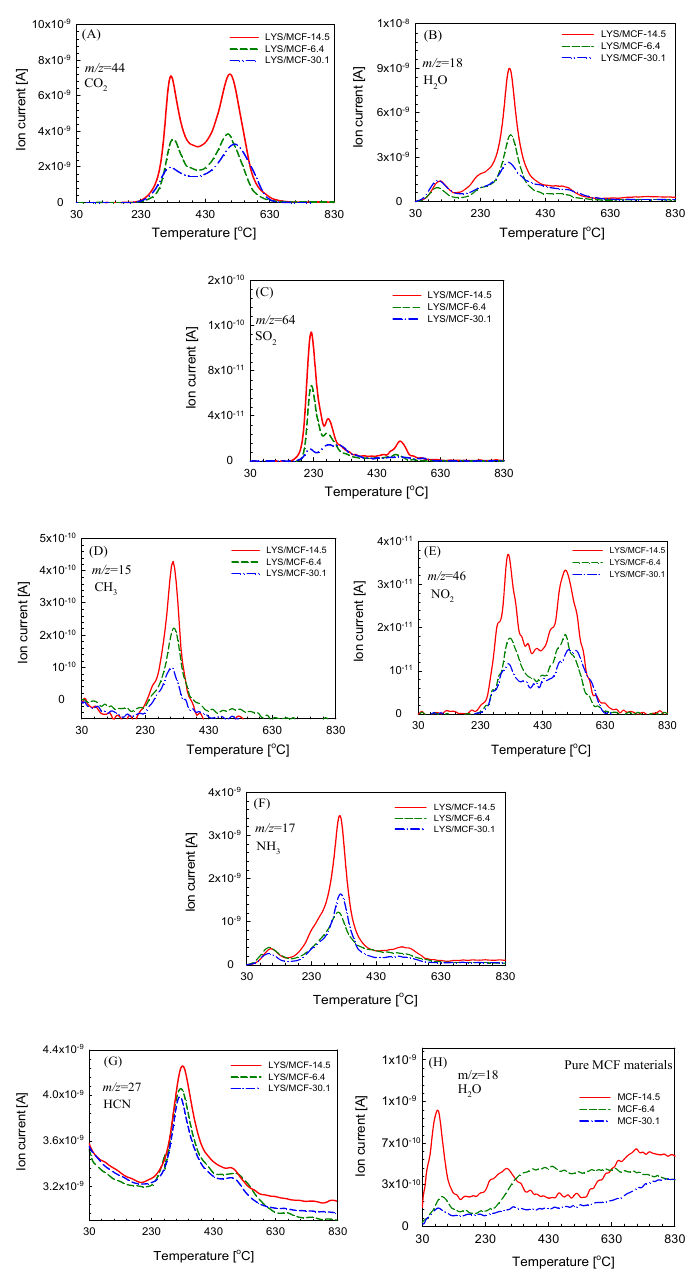
Figure 6. QMS profile of gaseous products emitted during decomposition of three selected LYS/MCF-14.5, LYS/MCF-6.4, LYS/MCF-30.1 composites vs. temperature at m/z : ( A ) 15 (CO 2 ); ( B ) 18 (H 2 O); ( C ) 64 (SO 2 ); ( D ) 15 (CH 3 ); ( E ) 46 (NO 2 ); ( F ) 17 (NH 3 ); ( G ) 27 (HCN) in air atmosphere; ( H ) MS profile of H 2 O vs. temperature for pure MCF-14.5, MCF-6.4 and MCF-30.1 supports. TG/QMS/FTIR results significantly indicate the formation of various gaseous products during the decomposition process of three studied biocomposites. At the main thermal degradation stages at T peak1 and T peak2 , the absorption bands at 2310 cm − 1 , 2360 cm − 1 and 669 cm − 1 characteristics for carbon